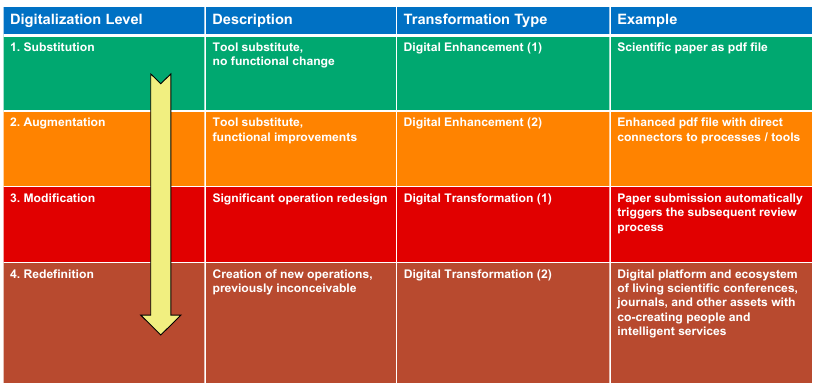
Figure 3. From digital enhancement to digital transformation. Adapted from [41].